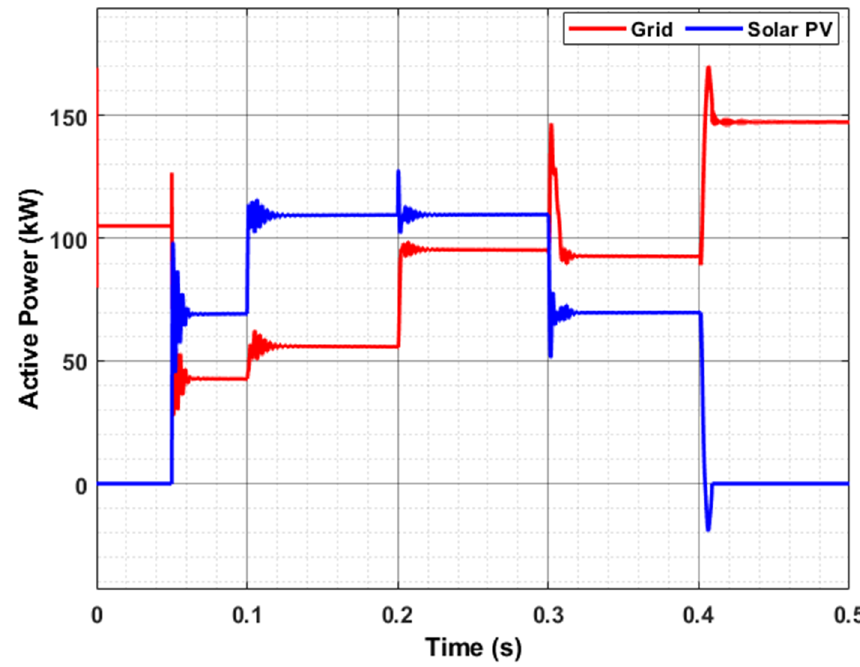
Figure 5. Active power-sharing between the utility grid and D.G.